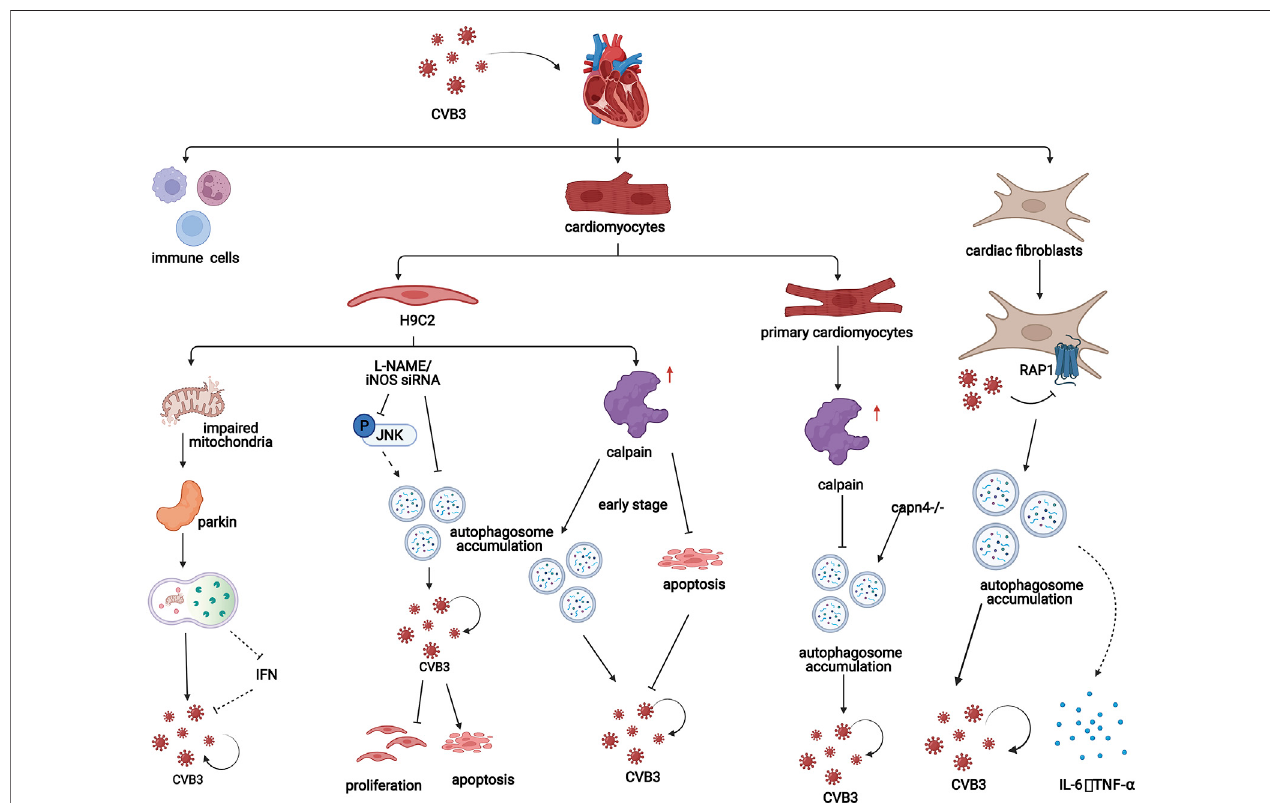
FIGURE 4 | In viral myocarditis, CVB3 in fl uences the process of autophagy in both cardiomyocytes and cardiac fi broblasts, which promotes disease progression through a variety of mechanisms. In H9C2 cells, mitochondrial structures are destroyed by CVB3, which induces mitochondrial autophagy in a Parkin-dependent manner.Additionally,iNOS inhibition attenuates CVB3-inducedautophagyactivation,increasingcellproliferation, andsuppressing cellapoptosis. Moreover,inthe early stageofCVB3infection inH9C2cells,calpain isbene fi cialforviralreplication bypromoting theformationofautophagosomesandinhibitingapoptosis.However,in a study ofcardiomyocytes from CVB3-infectedsucklingmice, inhibiting calpain promoted the formation ofautophagosomes and CVB3 replication. In fi broblasts, CVB3 promotes the formation of autophagosomes by inhibiting PAR1 and subsequently contributes to the replication of CVB3 and the release of in fl ammatory factors.